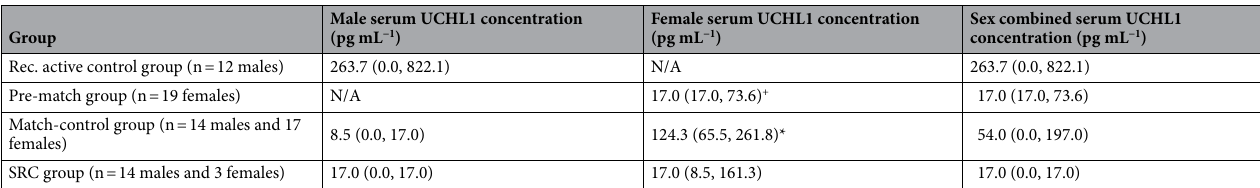
Table 3. Serum ubiquitin carboxyl-terminal esterase L1 (UCHL1) concentration among groups and between sexes. All subjects were Caucasian. Values are presented as median (Q1, Q3). Rec. = Recreationally, SRC = Sport-related Concussion group, Q1 = 1st quartile, Q3 = 3rd quartile. * = Significantly different compared to male match-control group (p = 0.002), + = Significantly different compared to female match-control group (p = 0.041).